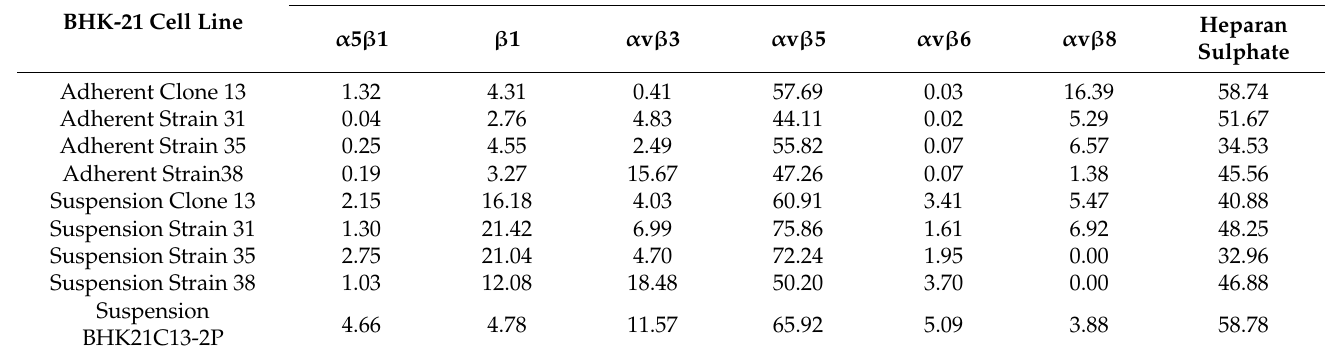
Table 1. Flow cytometry analyses of integrin and heparan sulphate expression on the cell surface of BHK-21 cell lines. Four adherent cell lines (BHK-21 Strain 31, 35 and 38, and BHK 21 Clone 13), and the respective suspension cell lines generated from them (SP Strain 31, 35, and 38, and SP Clone 13) were analyzed by flow cytometry using a panel of antibodies recognizing α 5 β 1, β 1, α v β 3, α v β 5, α v β 6, α v β 8 and heparan sulphate. BHK21C13-2P was analyzed alongside and served as a comparative suspension cell line. Matched isotype antibodies served as negative controls and the expression of each receptor is presented as the percentage of positive